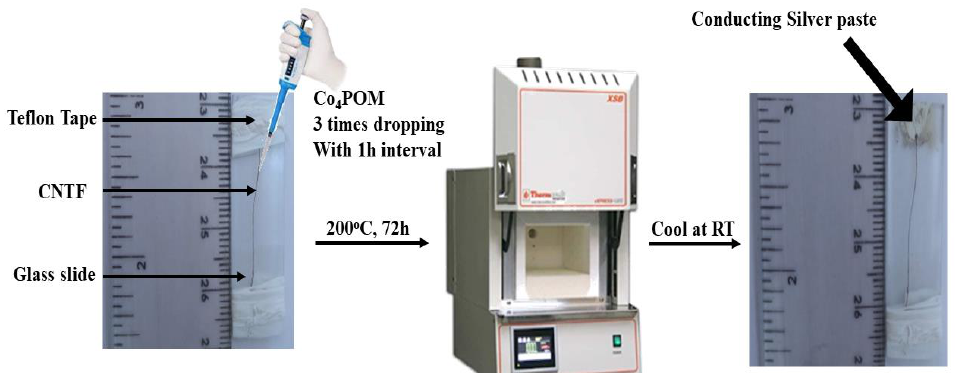
Figure 6. Schematic illustration of electrode fabrication by drop casting.